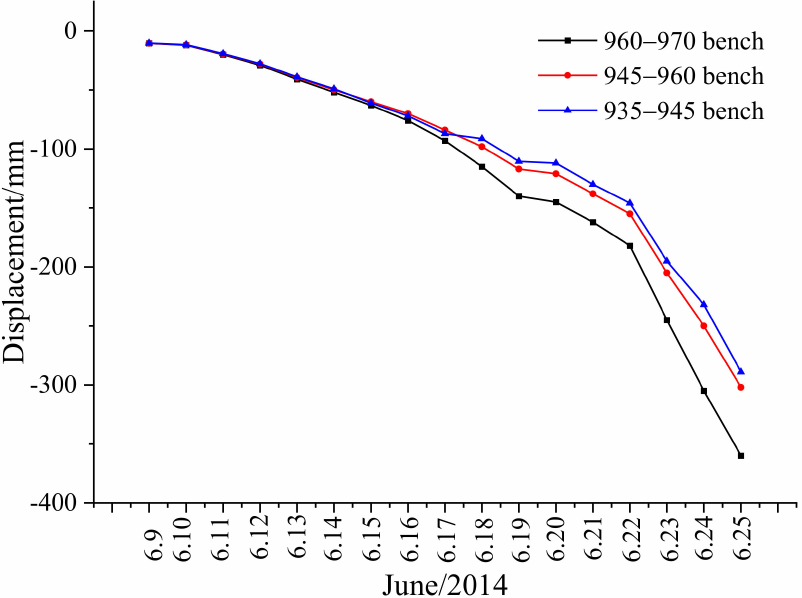
Figure 15. Displacement variation during rainfall by radar monitoring in June